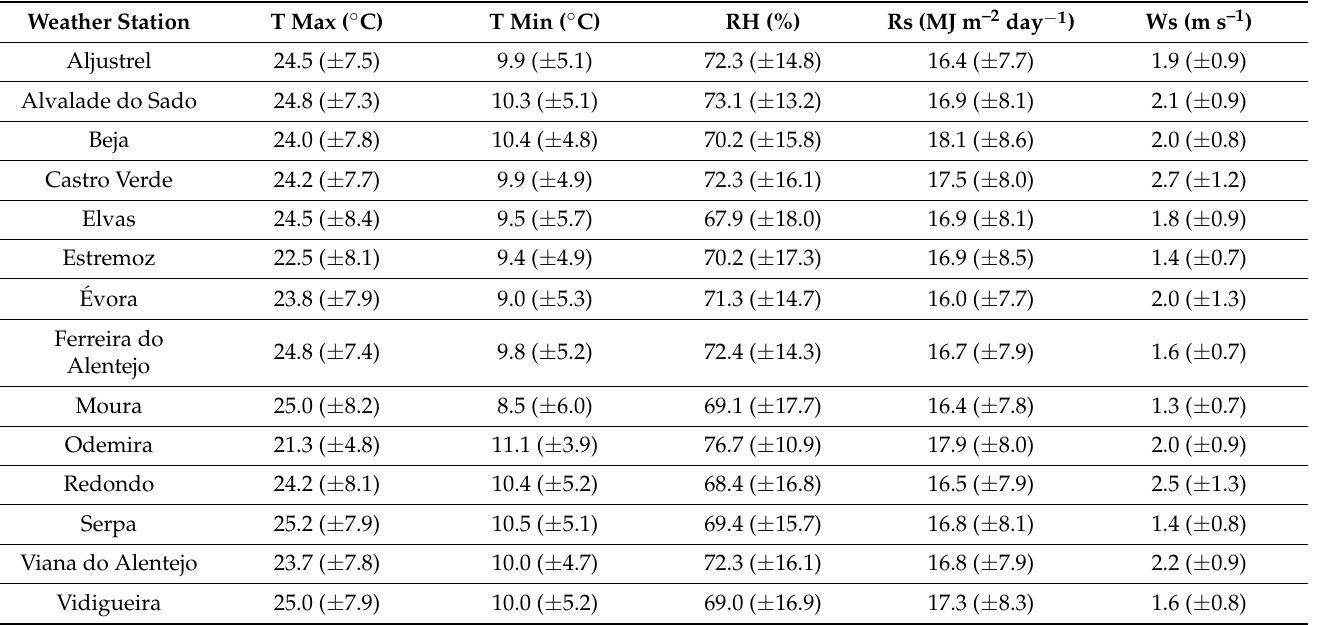
Table 2. Annual mean and standard deviation of maximum (Tmax) and minimum (Tmin) temperatures, mean relative humidity (RH), solar radiation (Rs) and mean wind speed (Ws) at the selected weather stations. Weather